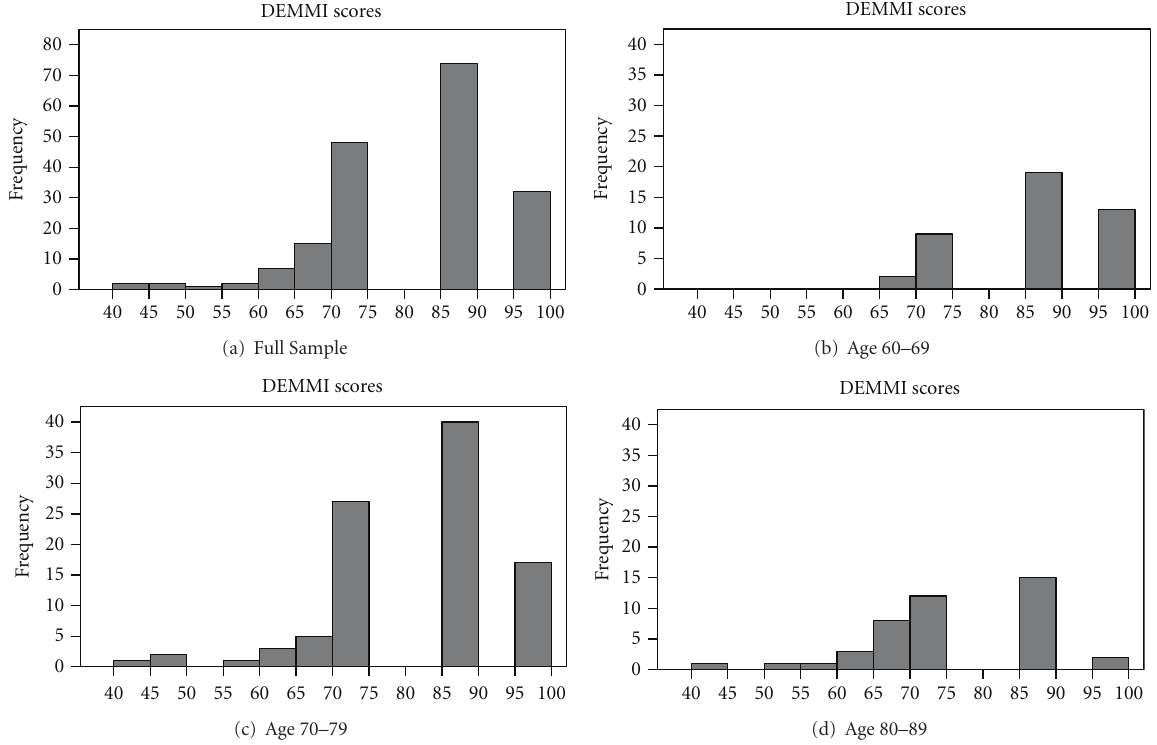
Figure 3: Histogram showing DEMMI scores for (a) total sample and (b) through (d) by age category (note category 90+ contained only 1 participant, therefore not represented graphically. Table 2: DEMMI normative Scores for group comparisons: mean, 95% confidence interval, and number in each subsample. Age